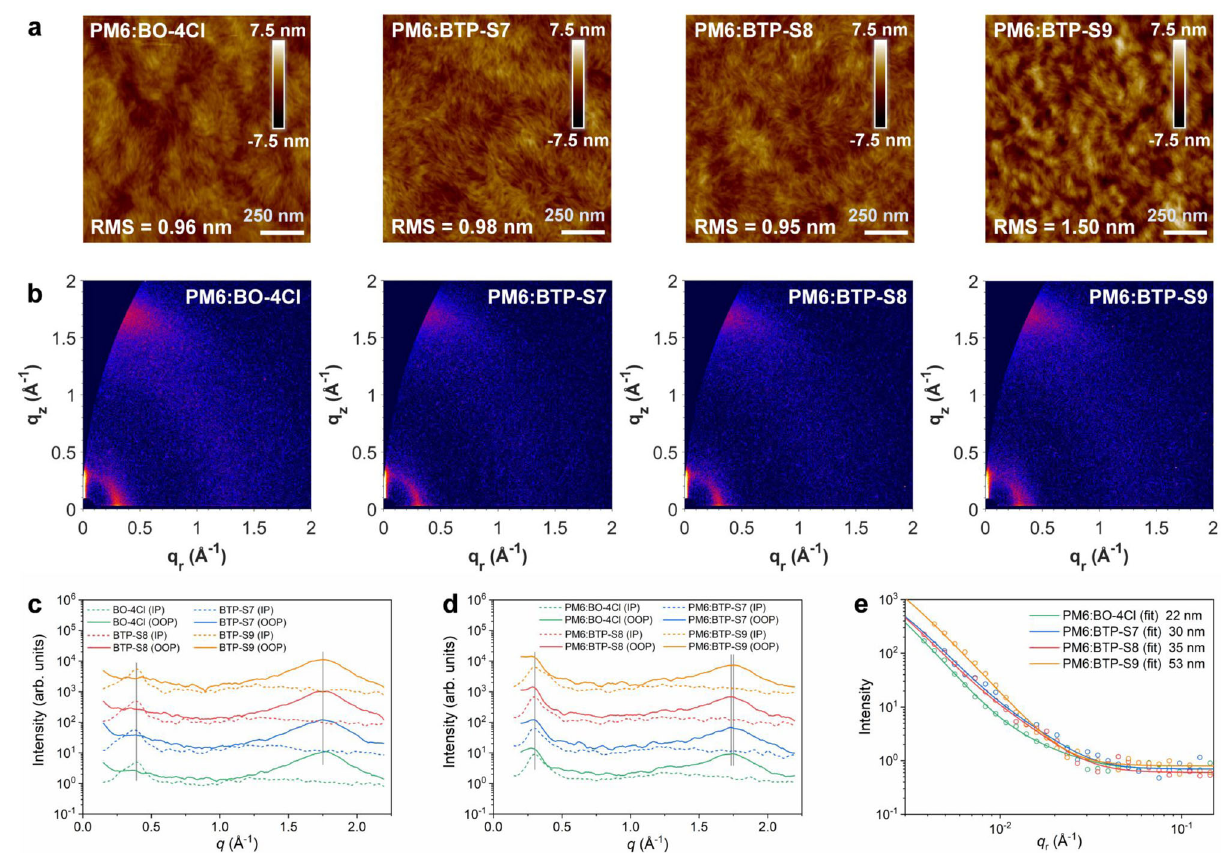
Fig. 4 Morphological characterization for fi lms. a AFM height images of PM6:BO-4Cl, PM6:BTP-S7, PM6:BTP-S8, and PM6:BTP-S9 blends. b 2D GIWAXS images of relevant blends. c 1D intensity pro fi les of BO-4Cl, BTP-S7, BTP-S8, and BTP-S9 neat fi lms. d 1D intensity pro fi les of relevant blends. e The intensity pro fi les along q r axis of relevant blends, extracted from 2D GISAXS